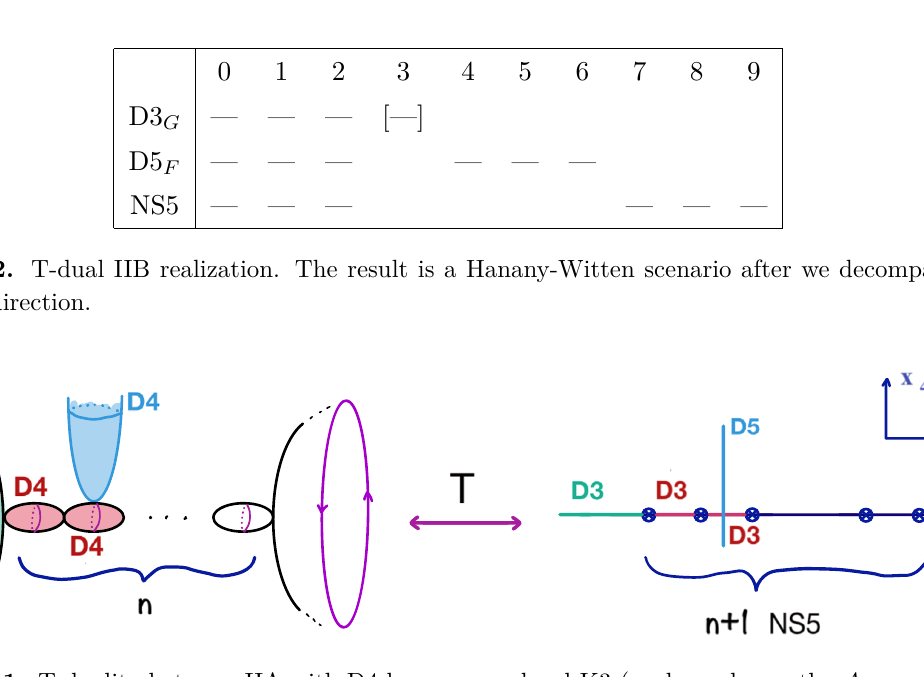
Figure 1. T-duality between IIA with D4 branes on a local K3 (we have drawn the A n case with n exceptional spheres) and IIB with NS5/D5 branes and D3